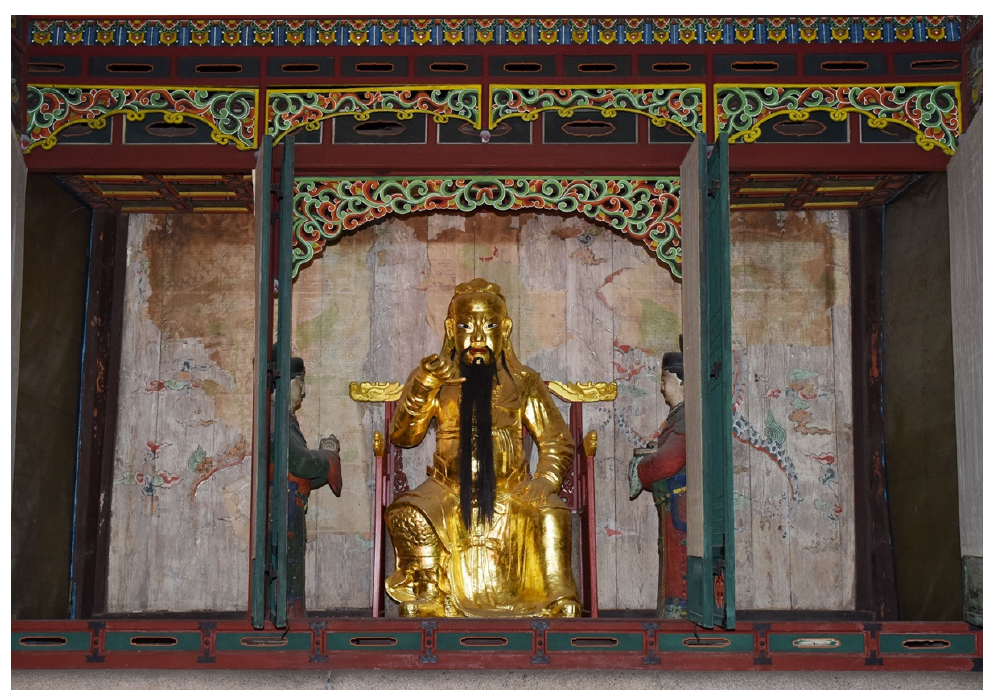
Figure 2. Kwanje (C. Guandi) with two female attendants , 1601. Main icon: gilt bronze, H 250 cm. Attendant figures: mineral colors on clay, H 187 cm. Main Hall of Eastern Shrine, Seoul. Image licensed under Creative Commons, reproduced with permission from the Korean Cultural Heritage Administration, Taej ŏ n.